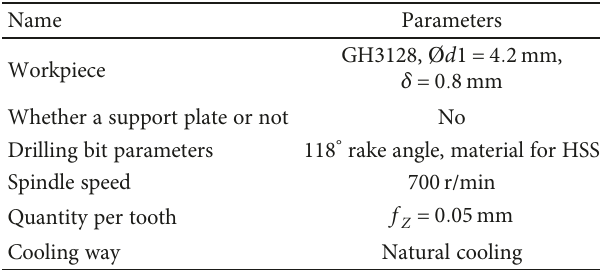
Table 8: The reaming process